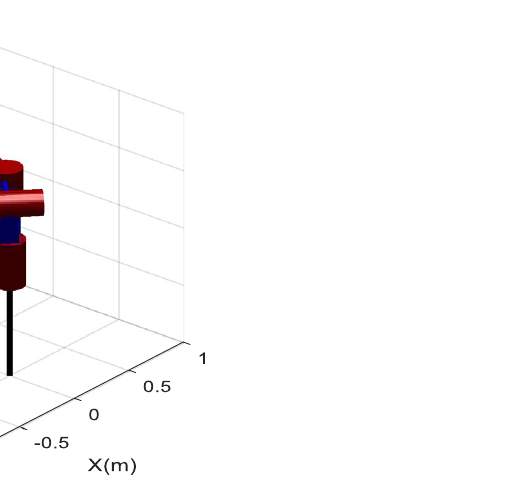
Figure 5. The structure of the 7-DOF robotic